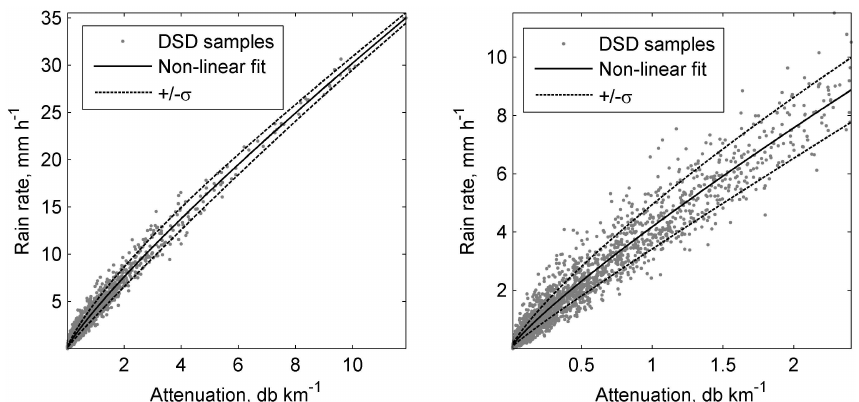
Fig. 4. An example of the power-law fit (Eq. 6) and predicted RMSE (Eq. 11) of path-integrated attenuation (Eq. 4) and path-averaged rain rate (Eq. 5) of the DSD database, including variations in DSD and wet antenna attenuation, for a 4km 20GHz link. The right figure is a zoomed version of the left